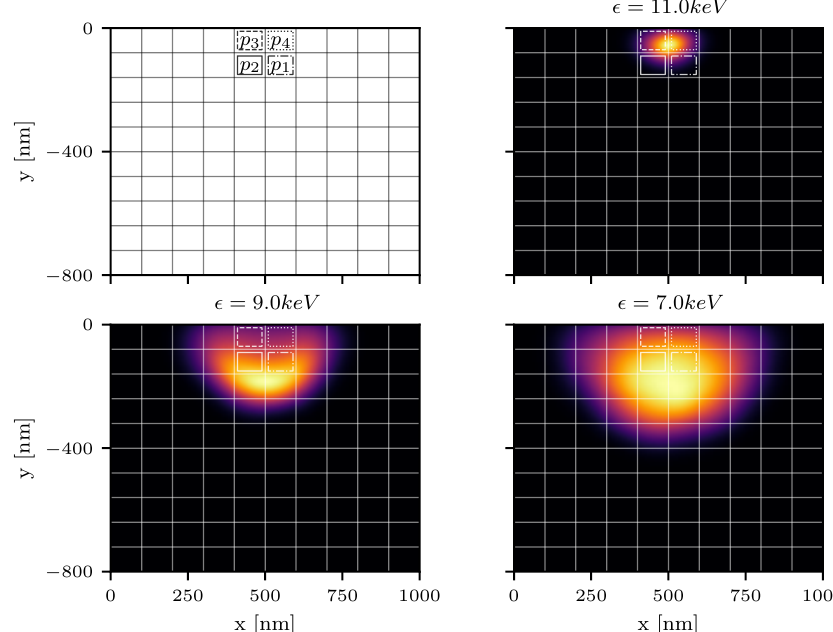
Figure 3. The electron fluence ψ 0 ( x , (cid:101) ) induced by a centered electron beam ( (cid:101) beam = 12 keV, σ (cid:101) = 0.1 keV and x beam = ( 500,0 ) T nm, σ x = 30 nm) for three different energies (cid:101) ∈ { 11,9,7 } keV. Discretization of the M 1 -model in ( n x , n y , n (cid:101) ) = ( 160,120, 170 ) . White lines indicate the size of the reconstruction pixel. The white dashdotted ( p 1 ), solid ( p 2 ), dashed ( p 3 ) and dotted ( p 4 ) pixel are reconstructed in Section 5.1.5.